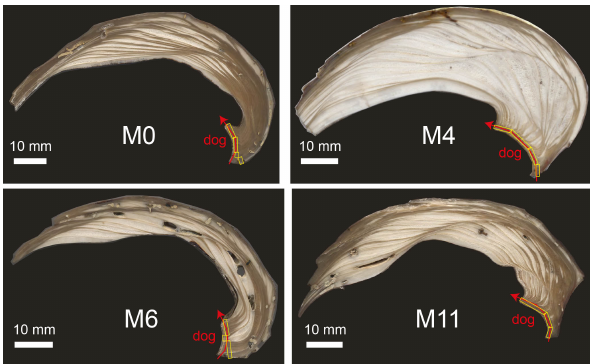
Figure 2. Colour scans of cross sections of the four shells subject to multi-proxy analysis. Red arrows indicate sampling location and direction. Yellow boxes indicate the location of stable isotope tran- sects. XRF sampling is in the direction of growth